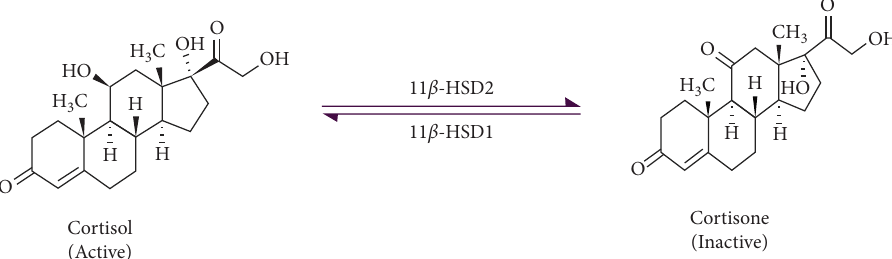
Figure 1: Interconversion of cortisol to cortisone via 11-ß-hydroxysteroid dehydrogenase type 2.